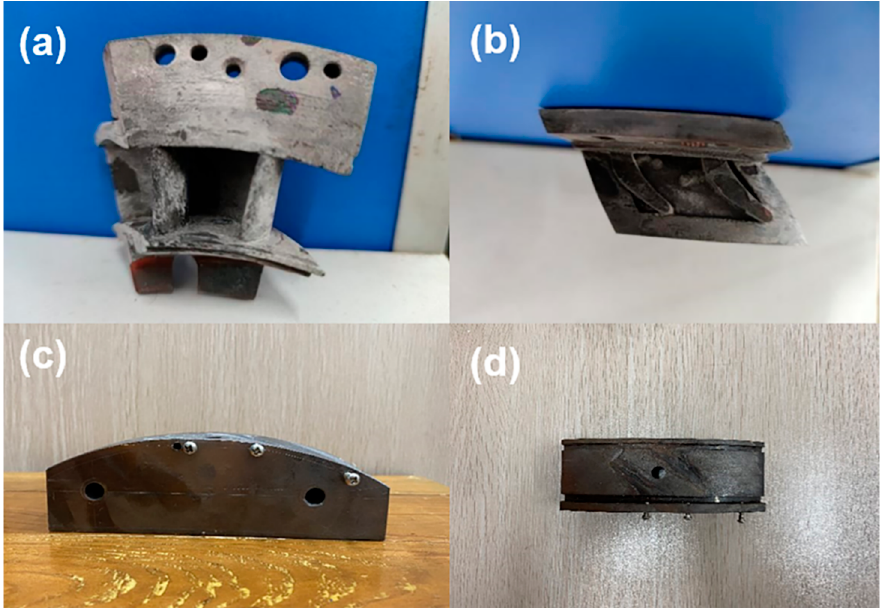
Figure 3. ( a ) Front view of the guide vane; ( b ) Top view of the guide vane; ( c ) Front view of the fixture; and ( d ) Top view of the fixture.